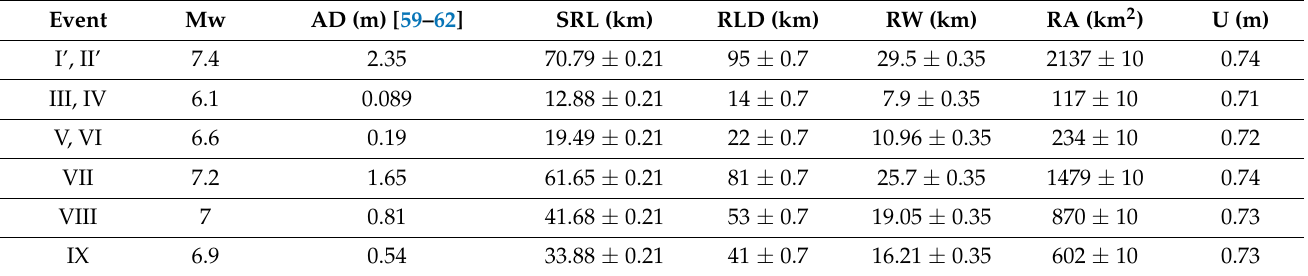
Table 4. Parameter survey results for AD, SRL, RLD, RW, RA, and u using equations (Equations